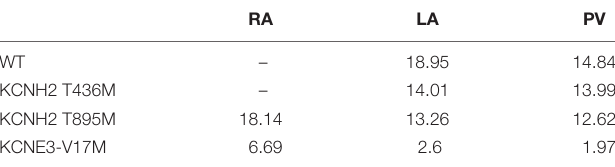
TABLE 3 | Areas of the ellipses (cm 2 ) surrounding rotor’s tip trajectories. RA